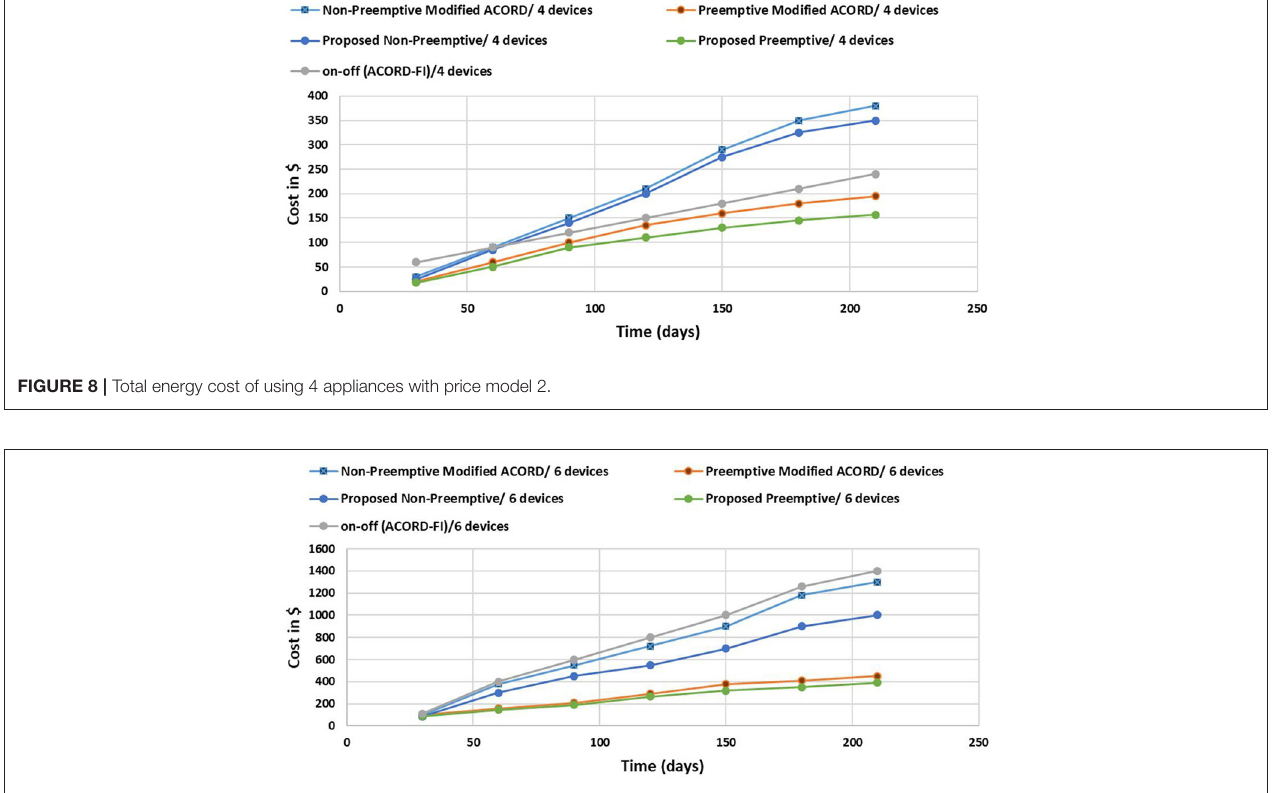
FIGURE 9 | Total energy cost of using 6 appliances with price model